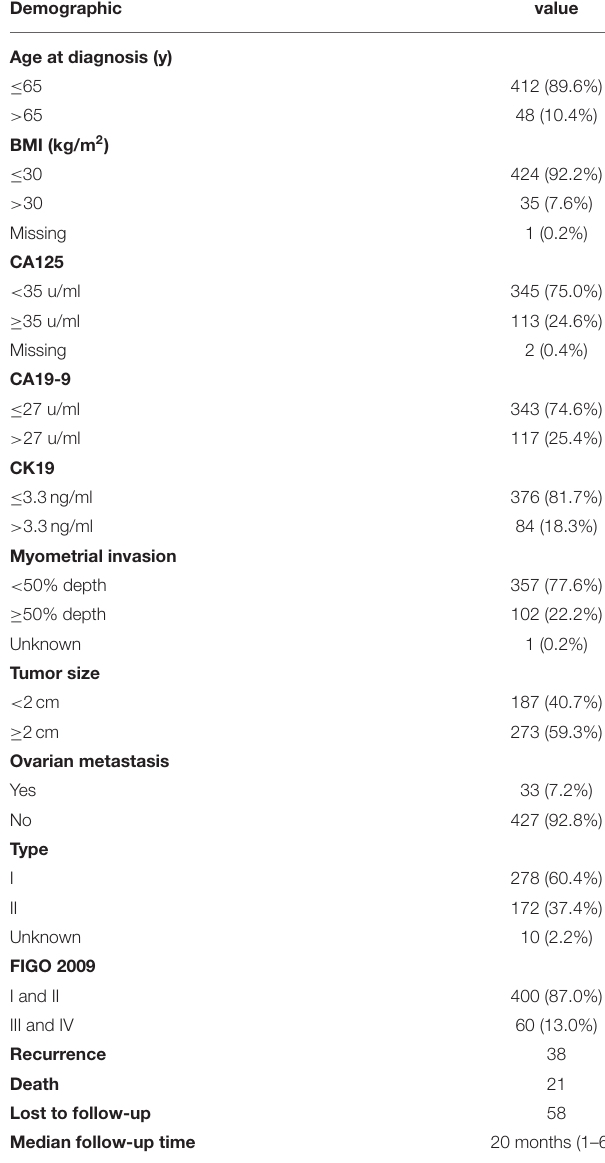
TABLE 1 | Demographics of patients ( n =